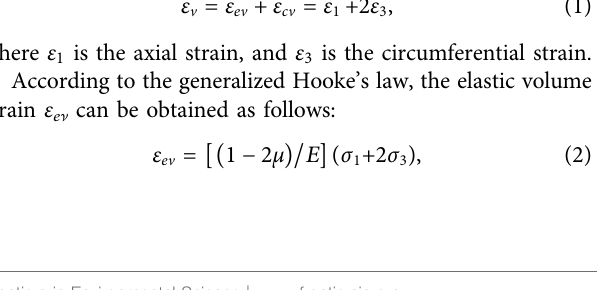
Frontiers in Environmental Science |